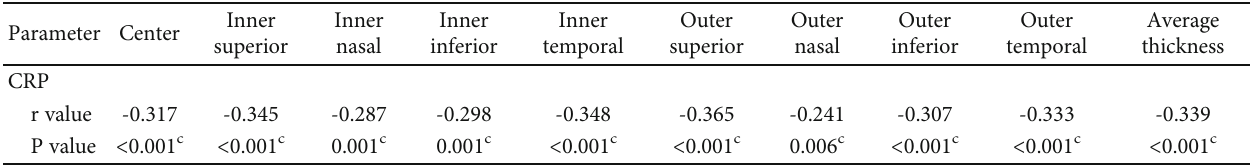
Table 5: Correlation analysis between CRP and choroidal